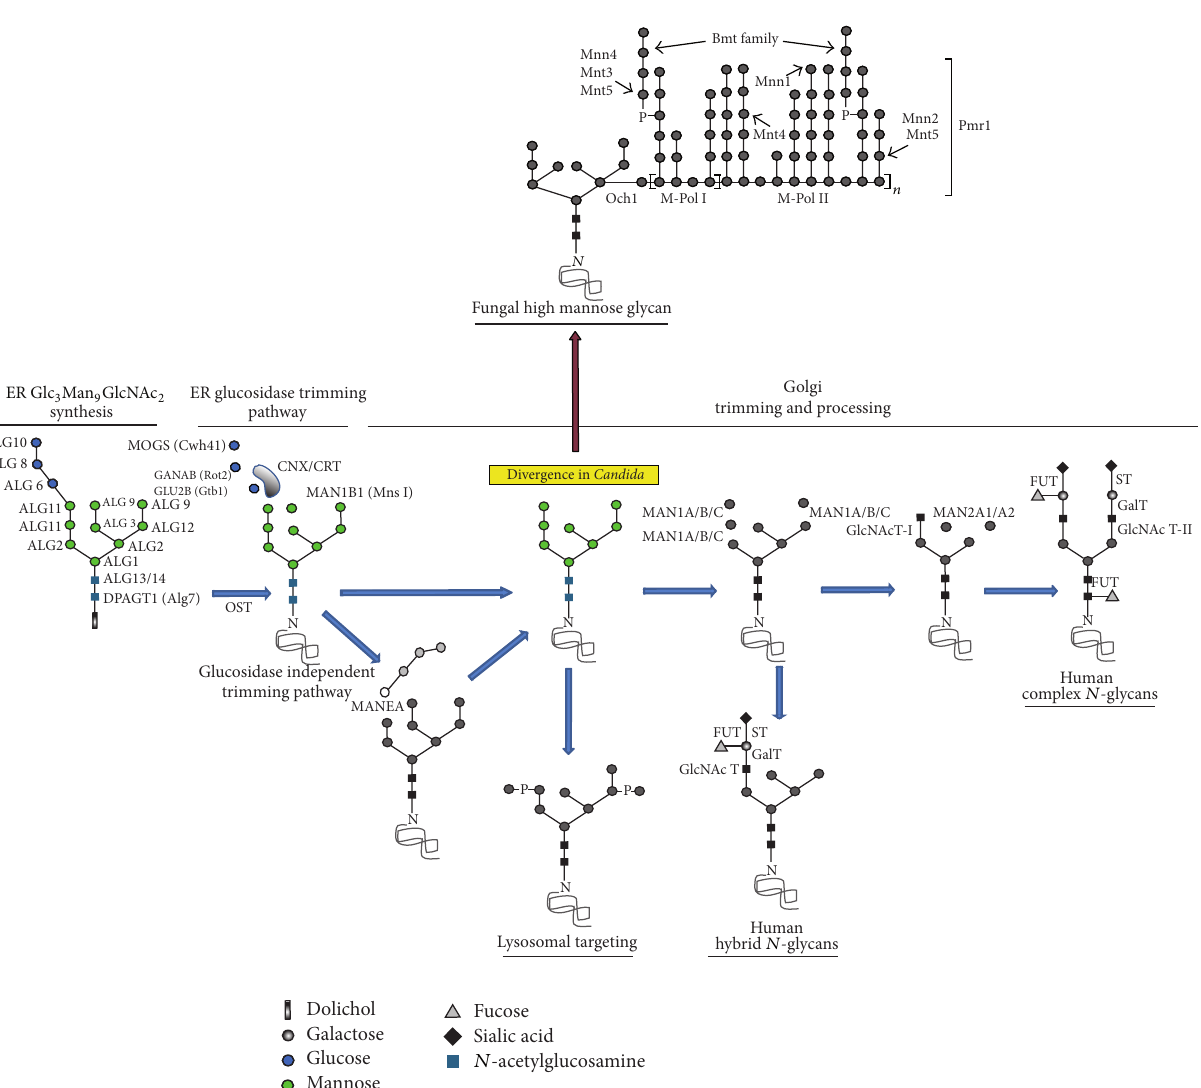
Figure 1: The N -glycosylation pathway. Commonalities and divergence in the N -linked glycosylation pathway. The shared structures between humans and Candida albicans have been colored, showing the rER synthesis of the Glc 3 Man 9 GlcNAc 2 glycan and its transfer by the OST complex to a nascent protein. Once transferred, the Glc 3 Man 9 GlcNAc 2 glycan is trimmed by the action of glucosidases and enters a quality control checkpoint performed by the CNX/CRT cycle. Once it passes this checkpoint, it is trimmed by mannosidase MAN1B1 to generate a Man 8 GlcNAc 2 structure. At this point divergence occurs with C. albicans that synthesizes high-mannose glycans. In humans, the Man 8 GlcNAc 2 structure is further demannosylated to Man 5 GlcNAc 2 by Golgi mannosidases type I (MAN1A, MAN1B, and MAN1C). This N -linked glycan suffers further demannosylation and glycosylation processing by type II mannosidases (MAN2A1, MAN2A2), N-acetyl- galactosaminyl transferases (GlcNAcT), galactosyltransferases (GalT), fucosyltransferases (FUT) and sialyltransferases (STs). In humans, a glucosidase-independent trimming of Glc 3 Man 9 GlcNAc 2 takes place, generating a Man 8 GlcNAc 2 structure. In addition, lysosomal targeting of glycoproteins through modification with phosphate groups is only found in human